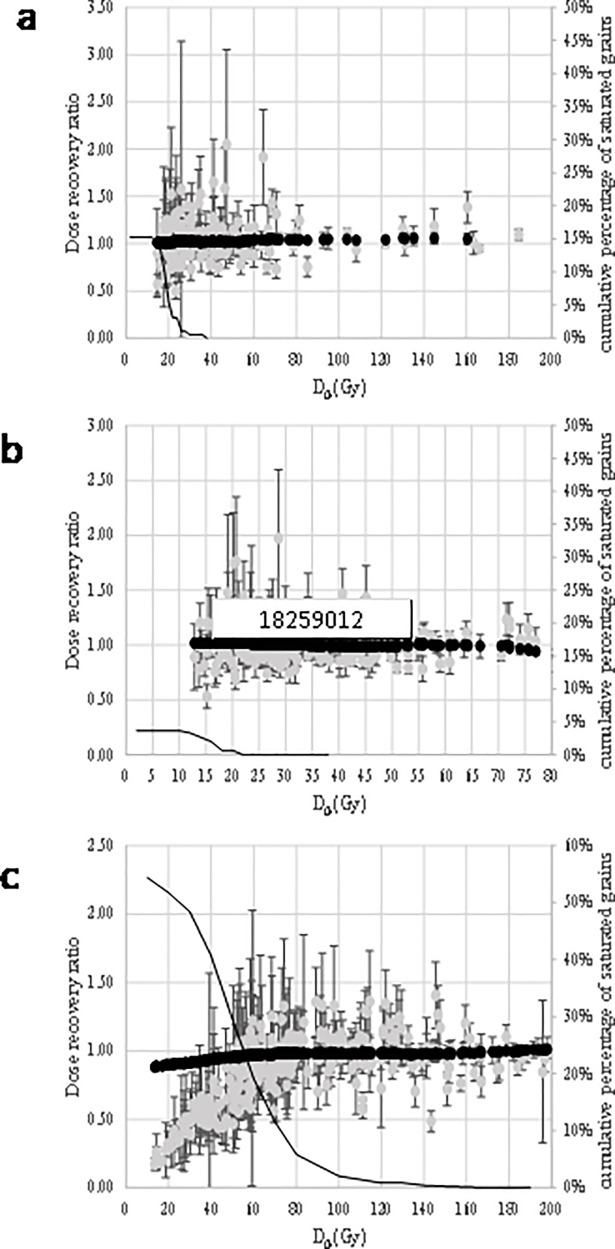
Dose recovery ratios in function of D0.a) BRS1, b) BRS2, c) BRS3. The grey dots represent the dose recovery ratio for each grain as a function of the D0 value of its growth curve. The black dots represent the central ratio while the grains with the lowest D0 values are progressively discard. The black line represents the cumulative number of saturated grains (in percent of the total number of grains passing criteria i to iv), as a function of the minimal D0 value.